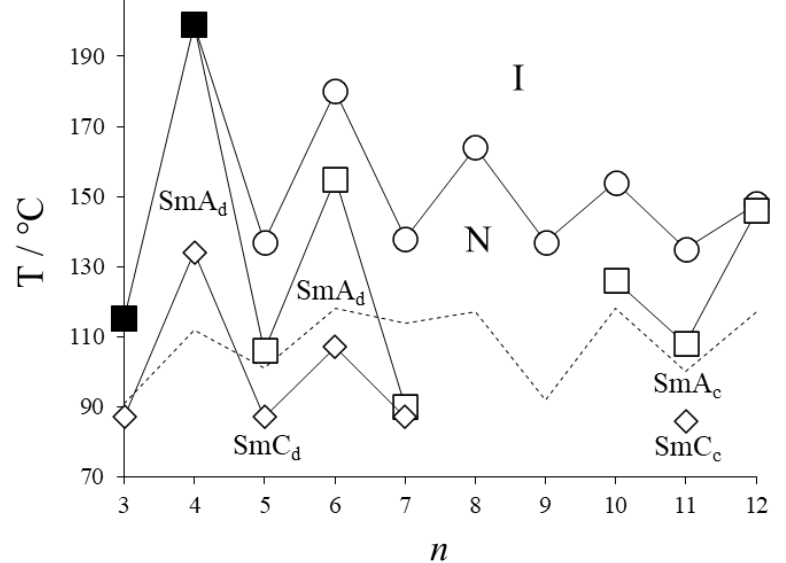
Figure 7. The dependence of the transition temperatures on the number of methylene groups, n , in the flexible spacer for the CBO n O.10 series [18]. The broken line joins the melting points. Filled squares denote T SmAI ; unfilled squares T SmAN ; circles T NI ; unfilled diamonds T SmCSmA .